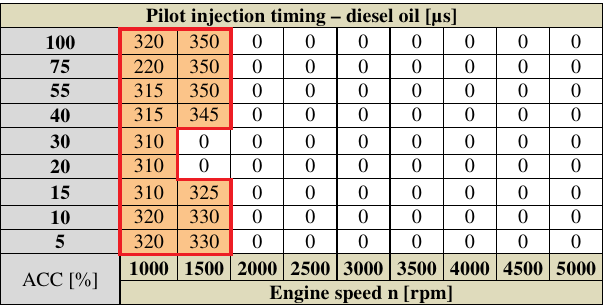
Table 2. Control algorithm of opening time of Diesel oil injectors for Pilot dose at dual fuel supply of the engine Pilot injection timing – diesel oil [µs]